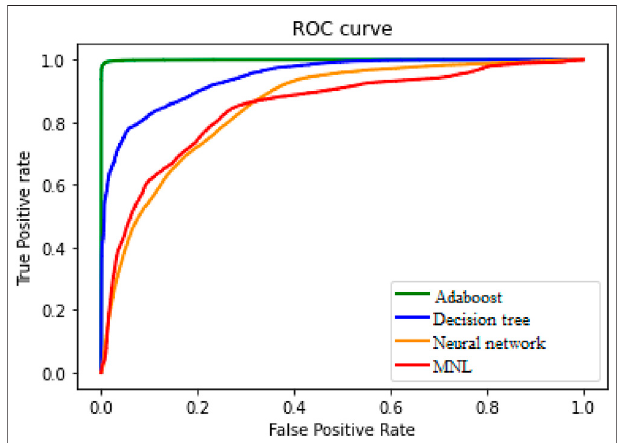
FIGURE 11 | ROC and AUC metrics for models